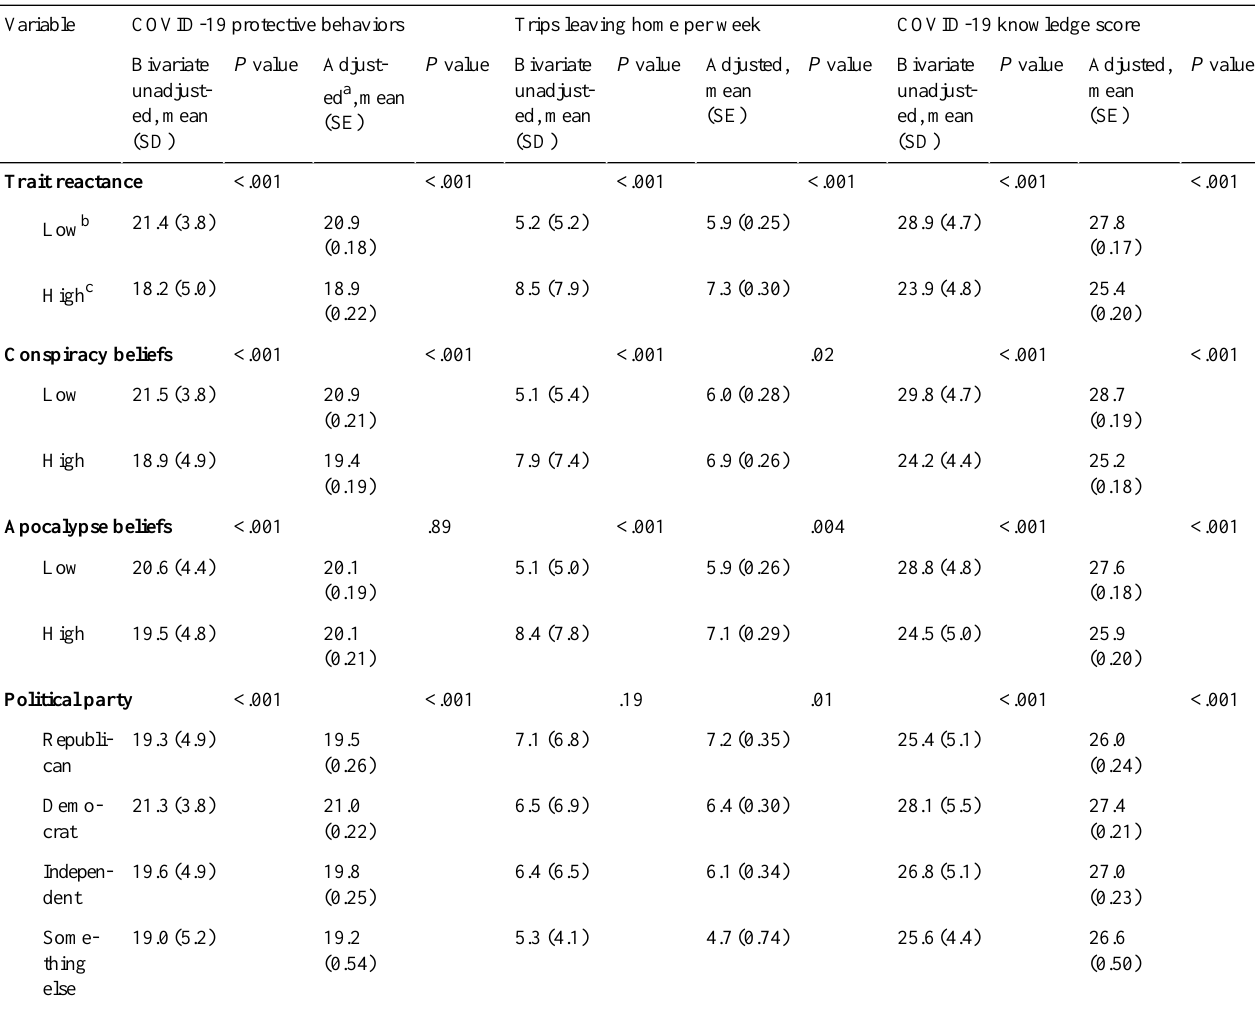
Table 3. Bivariate and adjusted means of COVID-19 protective behaviors, leaving home episodes, and COVID-19 knowledge by novel predictors